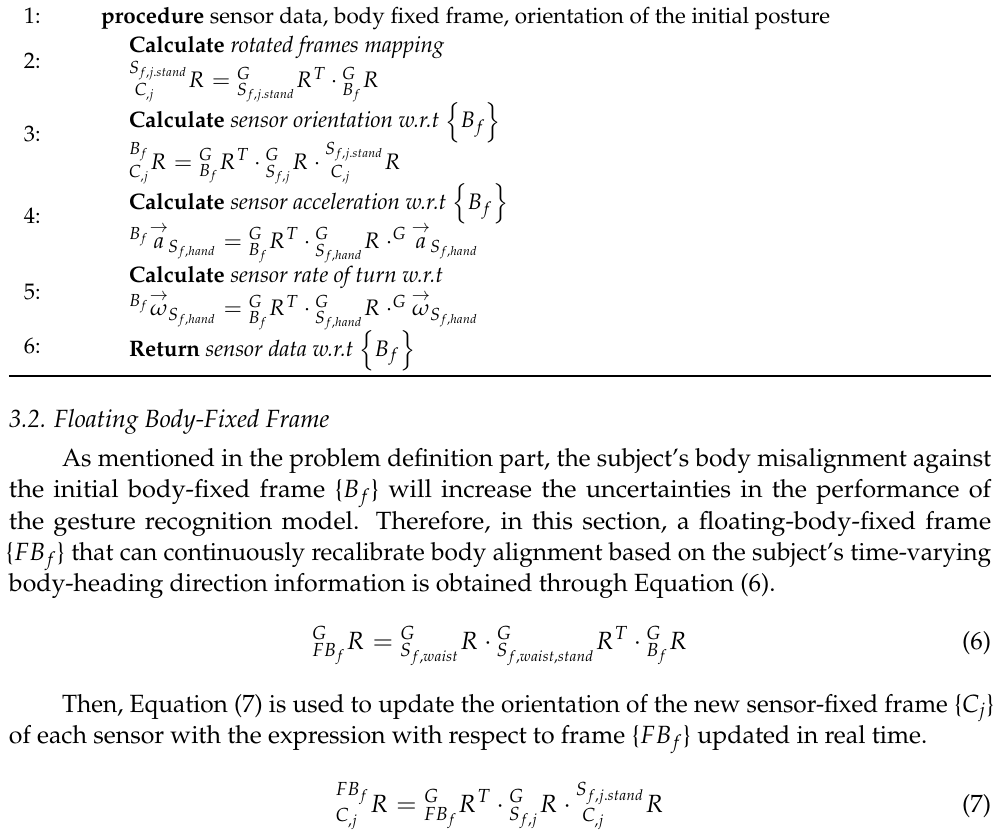
Algorithm 2 Align all sensor fixed frames